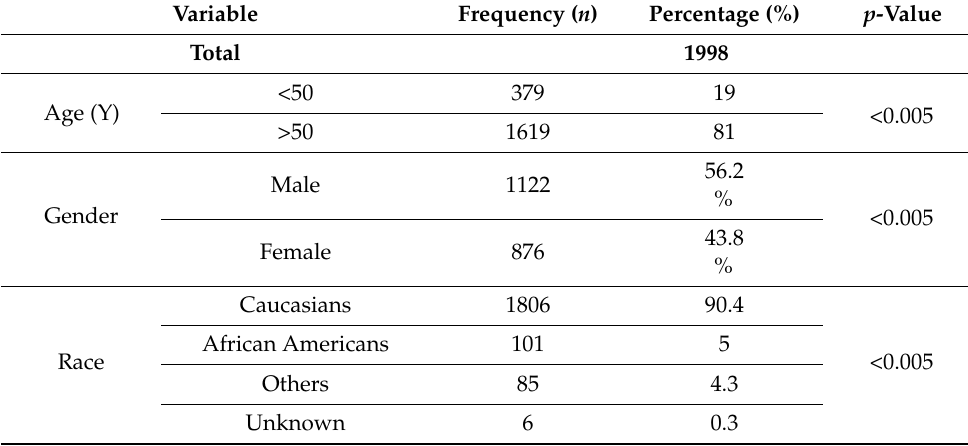
Table 1. Demographic Profiles of 1998 Patients with Primary Peritoneal Mesothelioma from the Surveillance, Epidemiology, and End Results (SEER) database, 1975–2016.